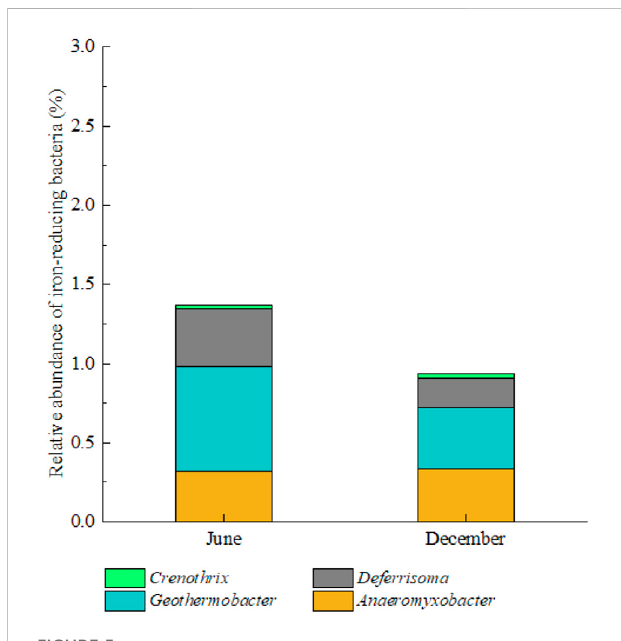
FIGURE 5 Genus-level classi fi cation of typical iron-reducing bacteria in the surface sediments in the two